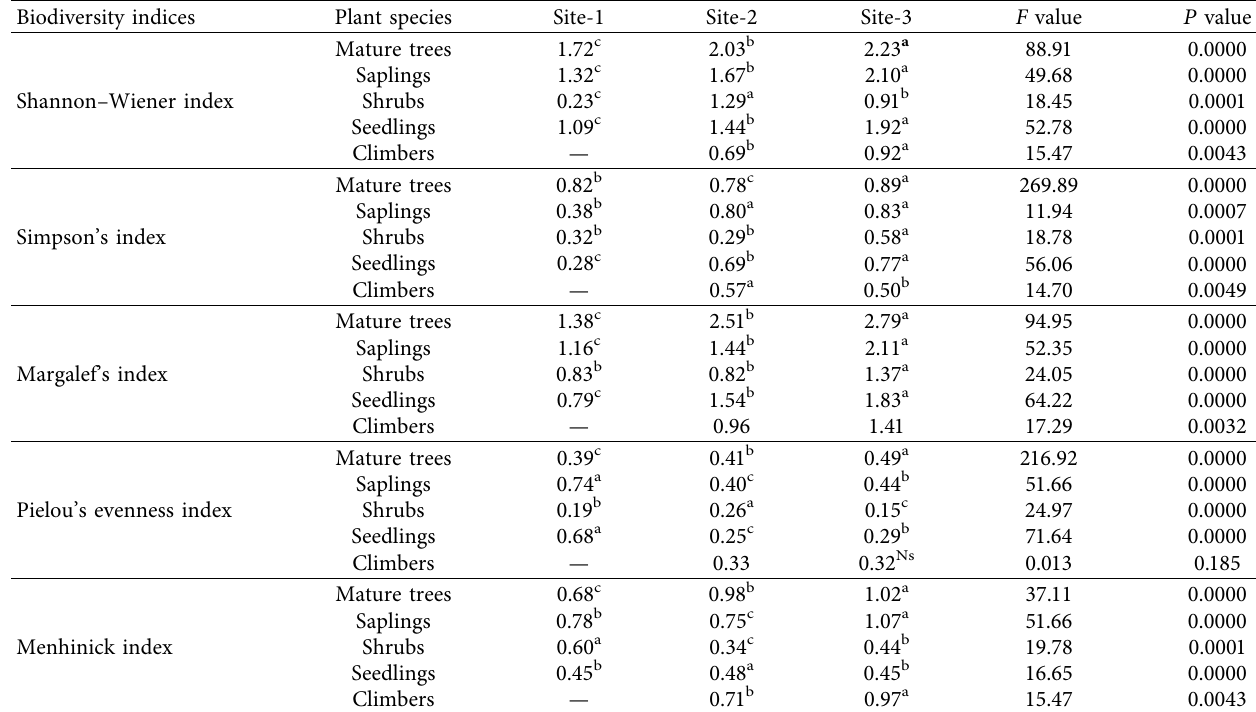
Table 7: Taxonomic diversity indices of the recorded species in the three sites of Bhawal sal forest.